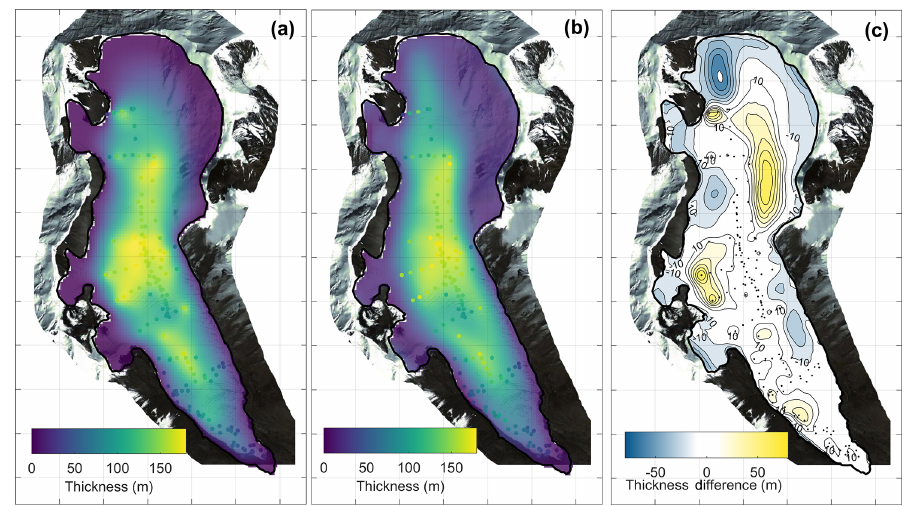
Figure 6. (a) Interpolated ice thickness from GPR measurements (dots in the three panels). (b) Ice thickness after bedrock topography smoothing and correction using free surface relaxation. (c) Difference between interpolated and corrected ice thickness and positions of the GPR measurements (black